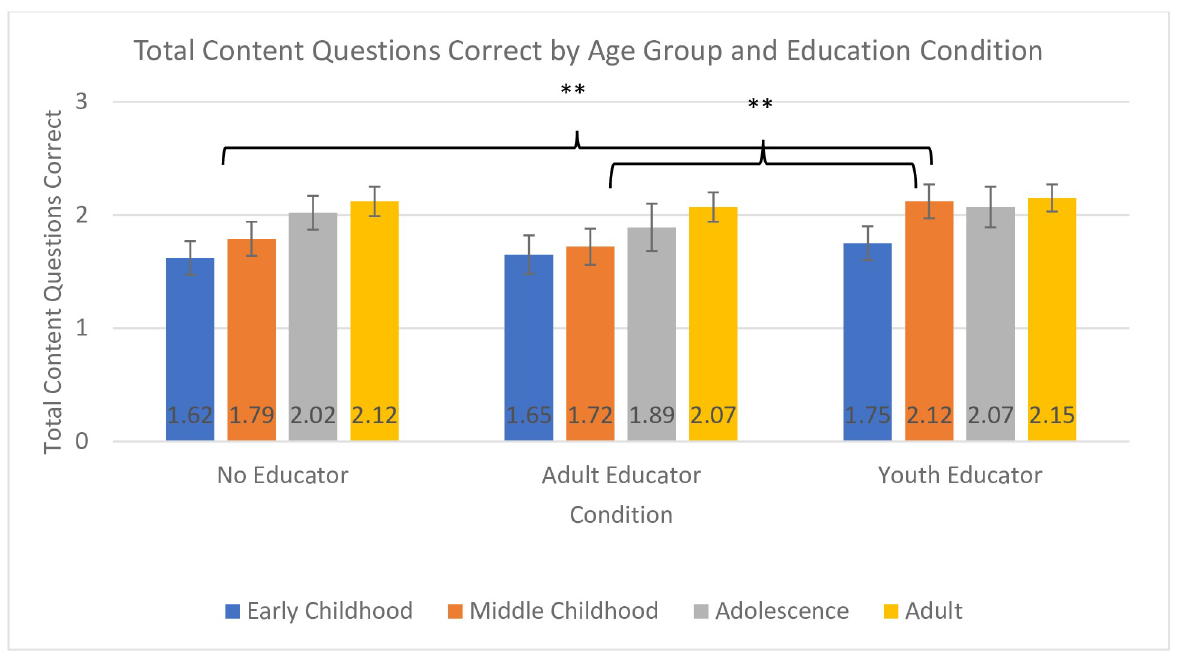
Fig 5. Total content questions correct by age group and condition. Analyses for children and adults were conducted separately, but are displayed in one graph for ease of interpretation across analyses; � p < .005, �� p < .01, ��� p < .001.